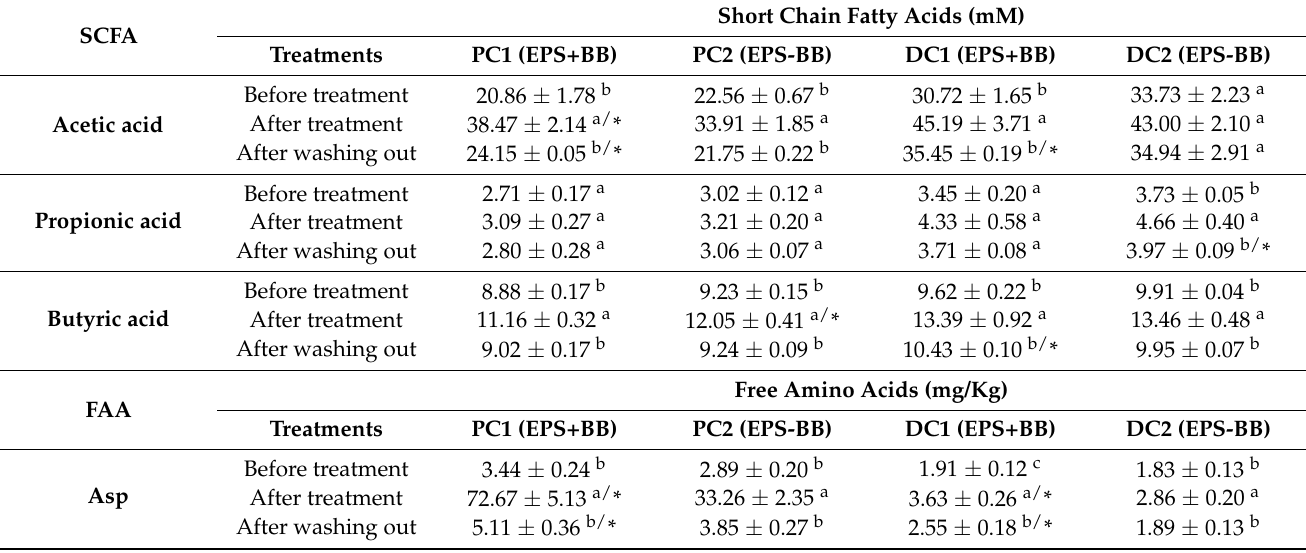
Table 6. Short chain fatty acid (SCFA) (mM) and individual free amino acid (FAA) (mg/Kg) concen- tration in proximal colon (PC) and distal colon (DC) tracts of the SHIME model, before and after treatment, and after washing out while fed with digested EPS+BB and EPS-BB. Sampling points refer to the end of the steady state period (i.e., before the start of treatment period), after one week of treatment period and after one week of wash out